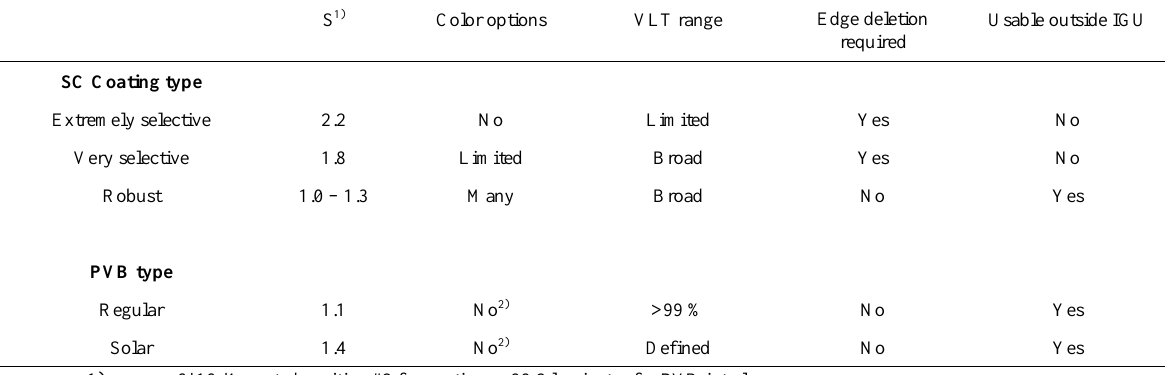
Table 1. Generic solar control coating and PVB interlayer solar